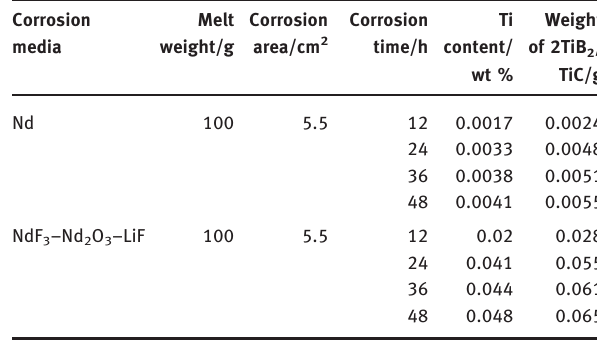
Table 1: Data used for calculating the corrosion rate.